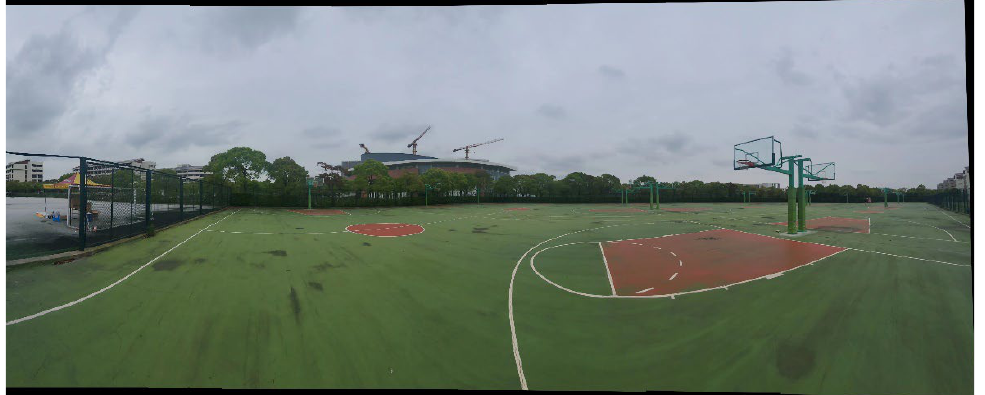
Figure 7. Results obtained with the left-to-right approach.